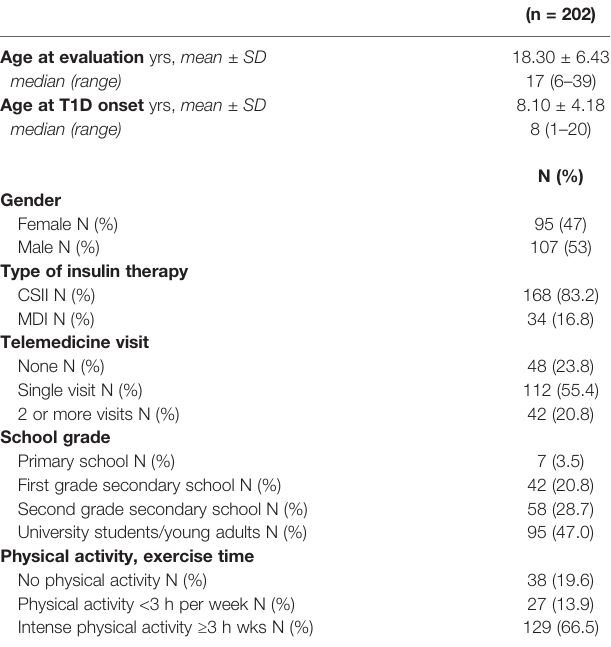
TABLE 1 | Demographic data, type of insulin therapy and weekly exercise time at